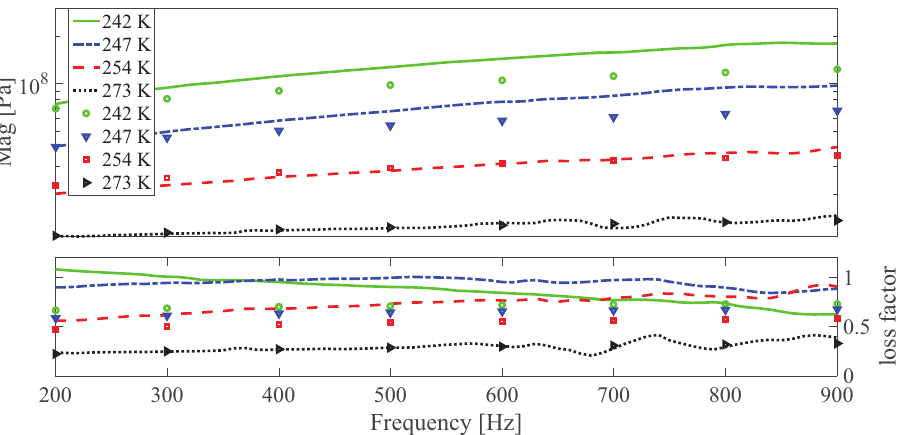
Figure 10. The magnitude and loss factor of the dynamic shear modulus versus frequency at 0.0005 strain amplitude and 0T under different temperatures. Lines and symbols are the simulation and measurement results, respectively.